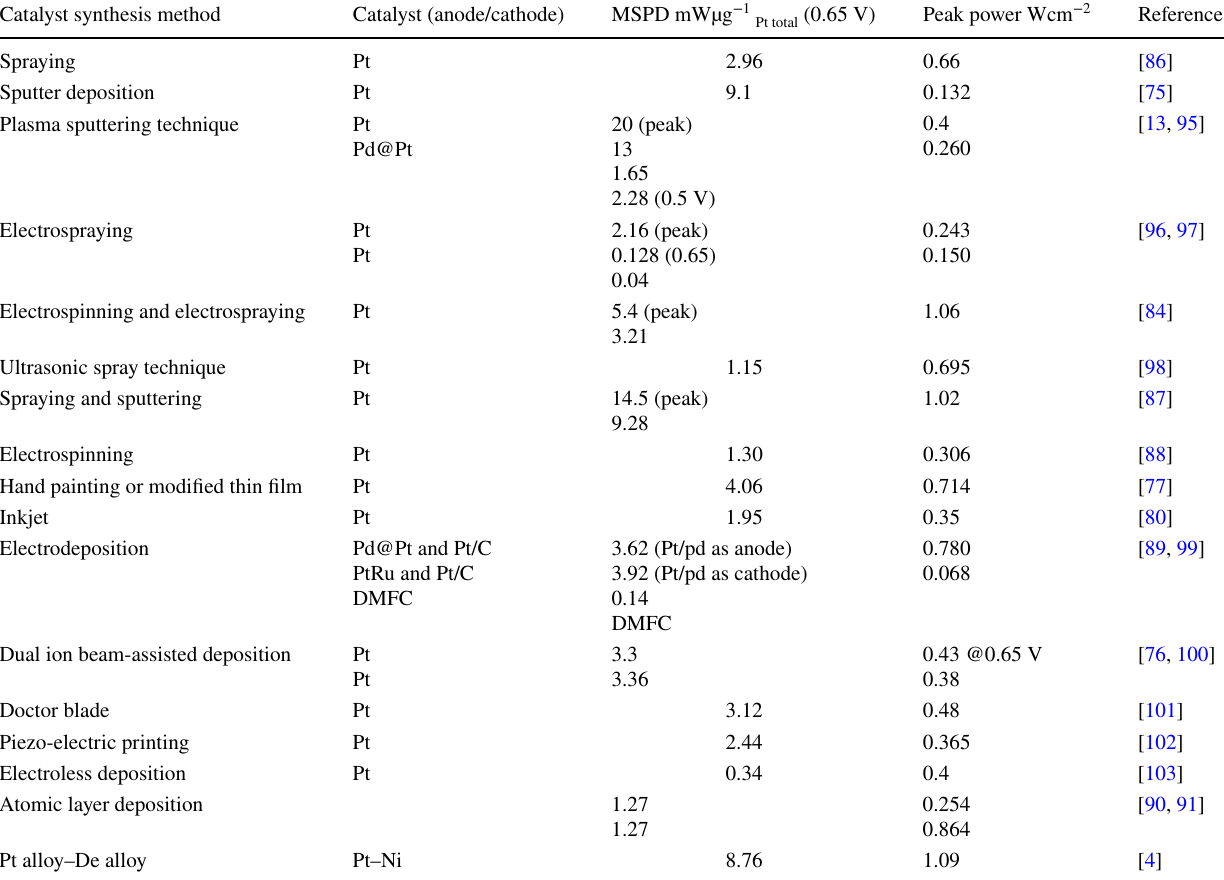
Table 4 Ultra-low loading of catalyst (both anode and cathode) by various synthesis methods, MSPD and peak power Catalyst synthesis